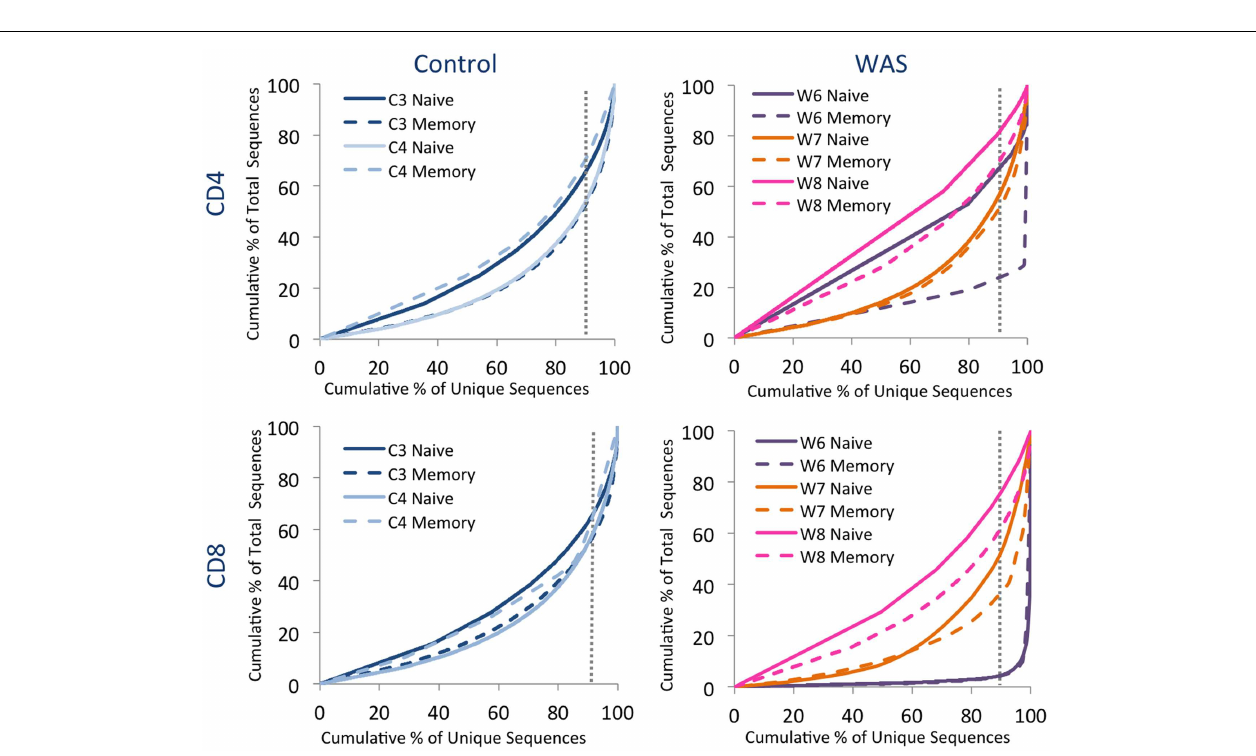
FIGURE 5 | J segment usage is skewed in theTRB repertoire of CD8 + cells inWAS patients . (A) Donut graphs compare the representative frequencies of TRBJ segment usage for total (inner ring) and unique (outer